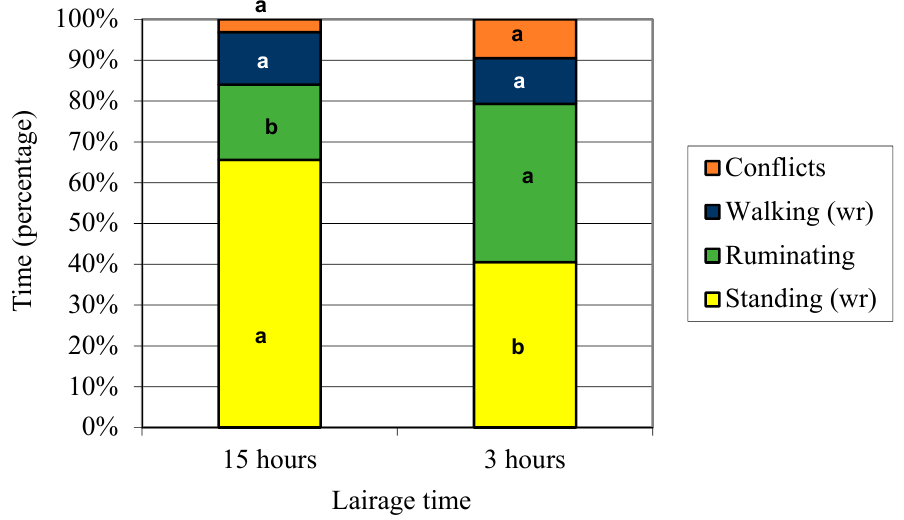
Figure 3. Percentage of the total time destined/allotted to each observed behavior by slaughter group. Note: The same activity with different letter (between bars) differs with p < 0.05.